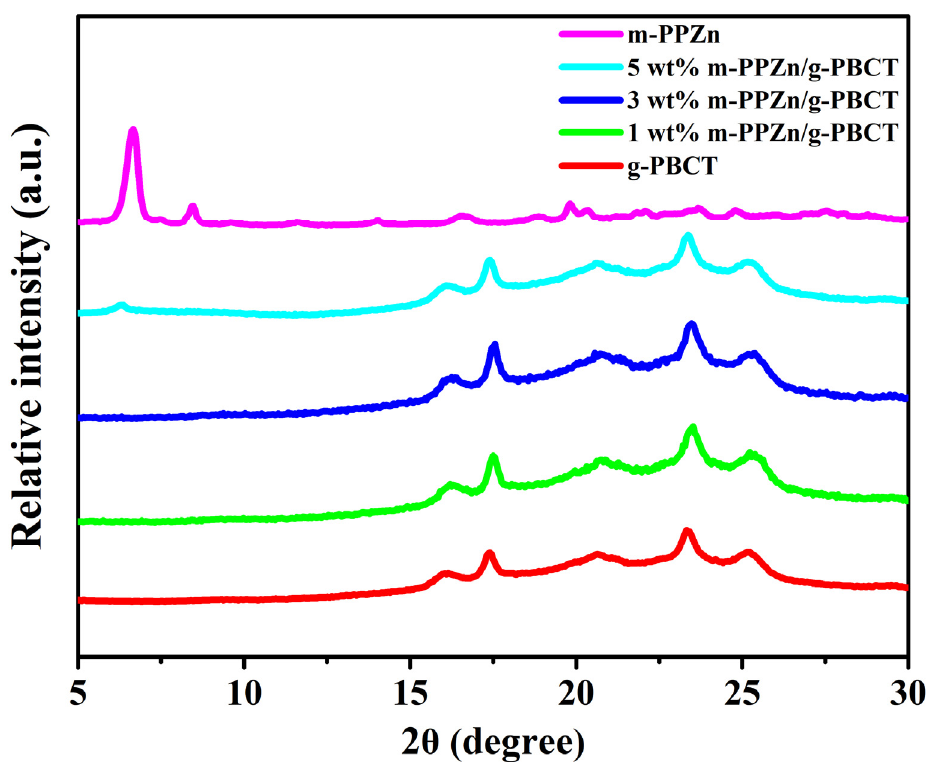
Figure 3. WAXD patterns of the m-PPZn, g-PBCT, and various weight ratios of g-PBCT/m-PPZn composites.